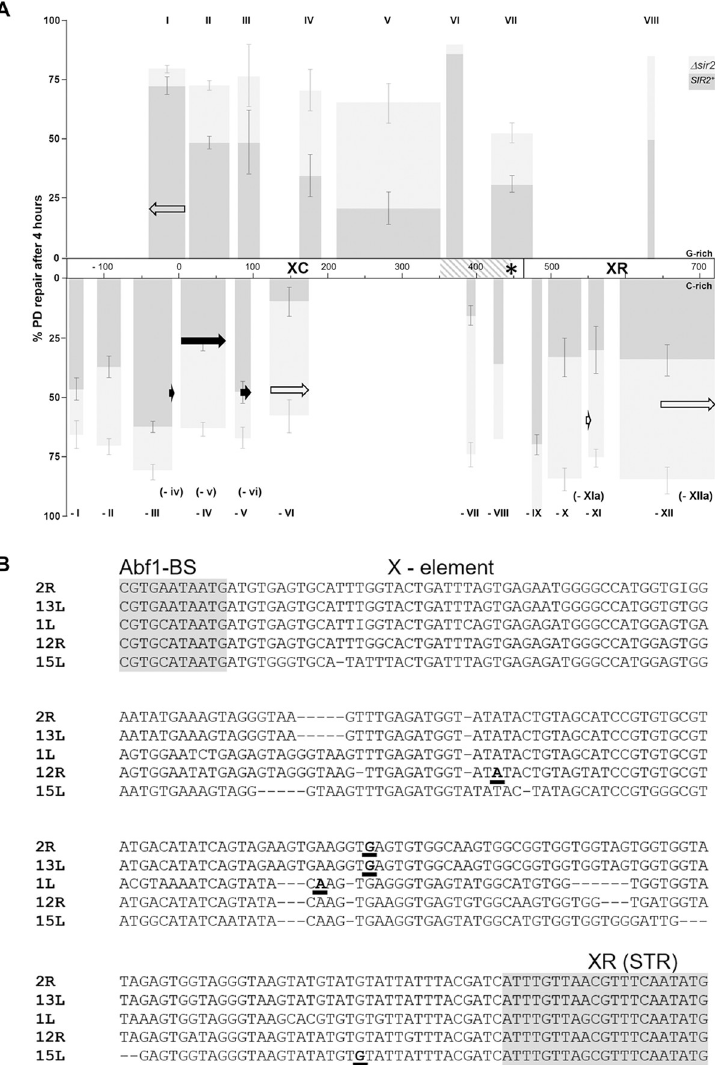
Fig 7. TCR assists GGR to remove PDs in Tel15L X-element silenced heterochromatin. (A) Column chart summarizing repair of PD clusters (roman numerals) in the G- and C-rich strand. The percent of repair after 4 hours was extracted from the repair plots for WT, rad26 Δ , sir2 Δ and sir2 Δ rad26 Δ cells ( Figs 3 , 4 , 6 and 9 ) and plotted against the Tel15L X-element DNA sequence. Dark and light grey columns denote the average repair of PDs by NER (GGR + TCR), in Sir2 containing ( SIR2 + ) and depleted ( sir2 Δ ) chromatin, respectively. Error bars ( ± 1SE) were calculated for clusters of 3 or more PDs. Black and white arrows denote the average repair of PDs by TCR, in SIR2 + and sir2 Δ cells respectively. The shadowed area at the end of the XC region represents the domain where the transcription start-sites (TTSs) were mapped for 5 telomeres, see (B). The star points to the TERRA TSS for the Telomere 15L. In the C-rich strand, between clusters -VI and -VII the assay could not be applied to identify PDs because primers cross-hybridized with unspecific repetitive DNA sequences or could not be extended by the TaqI polymerase. In the G-rich strand of the XR-region, only cluster VIII (PD 27; +635) was identified by the primer extension assay, reflecting the low content of potential PD forming sites in the DNA sequence. (B) DNA sequence similarities between the X-elements of Telomere 2R, 13L, 1L, 12R and 15L. The Abf1 binding site and the XR (STR) regions are in grey. Nucleotides in bold correspond to the TERRA transcription start-sites